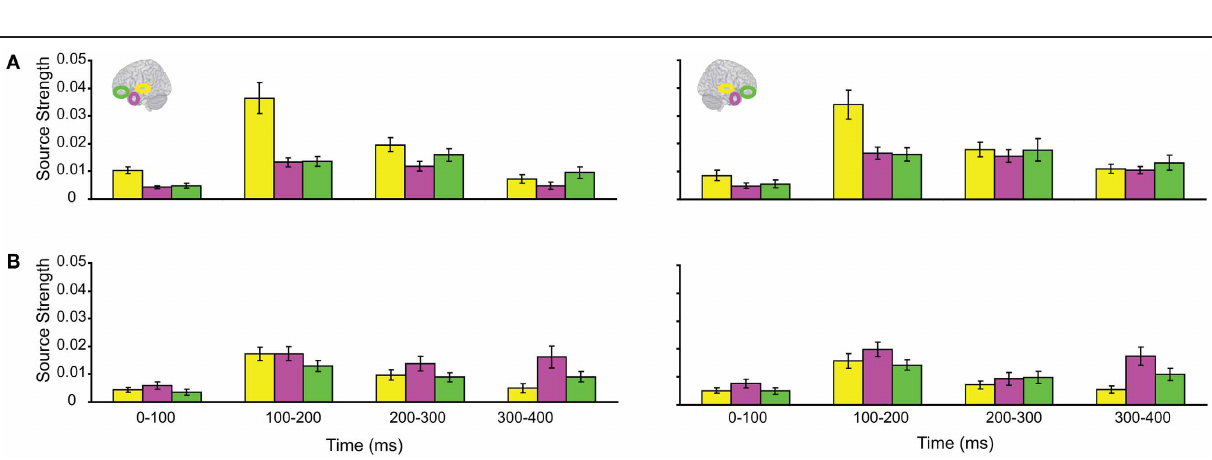
FIGURE 3 | Regional response waveforms averaged across participants during (A) the first sound, when integration could not yet occur, and (B) the second sound, when participants attempted to integrate the two sounds into a meaningful auditory object. Left/right panel displays left/right hemisphere.